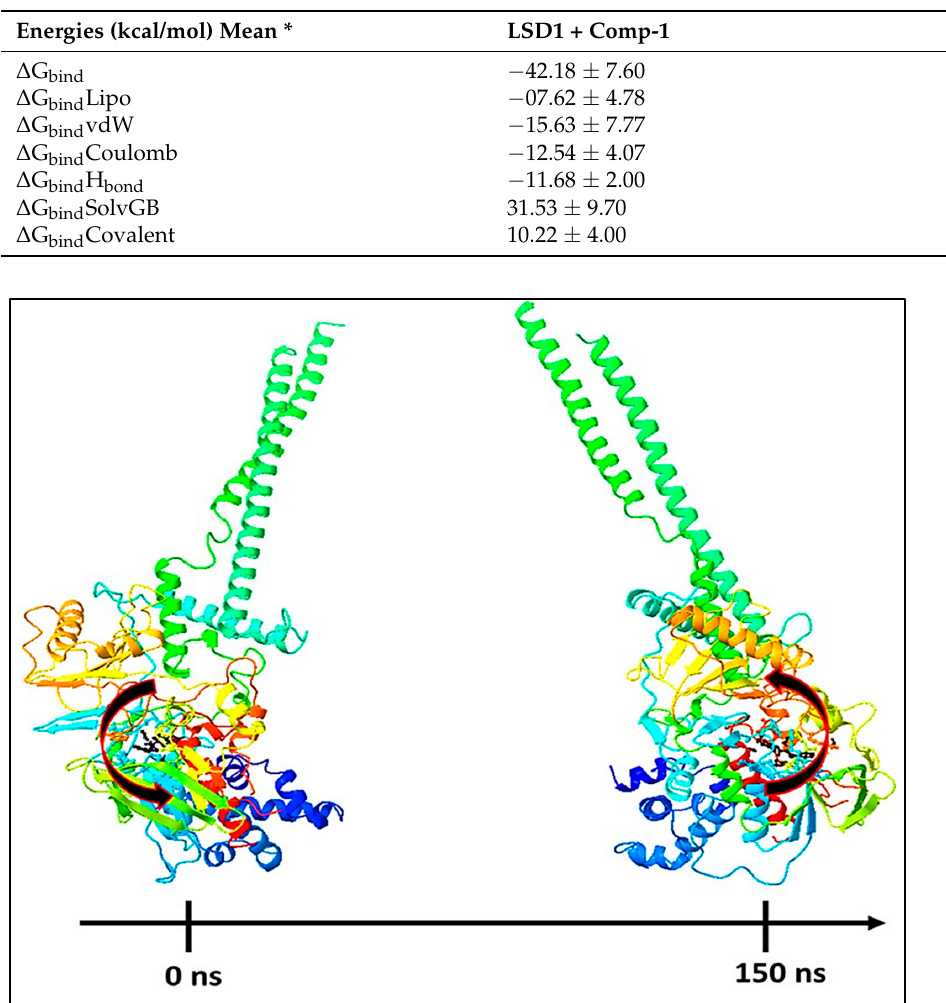
Table 1. Binding energy calculation of compound 1 with LSD and non-bonded interaction energies from MMGBSA trajectories. (star indicates mean of all th energy value).